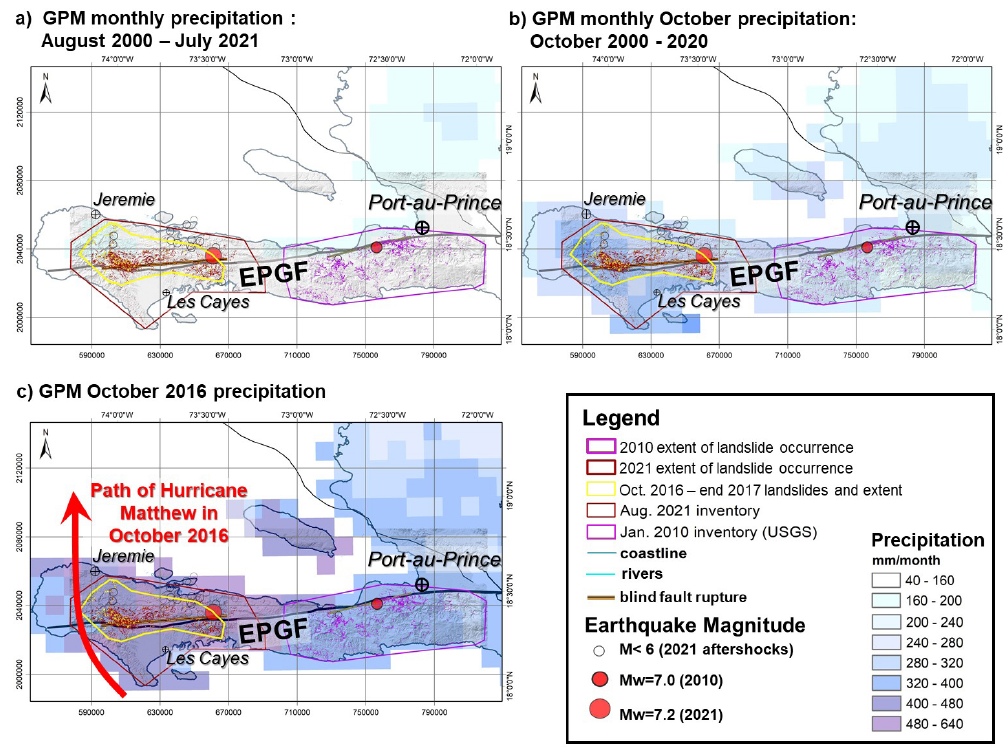
Figure 7. Monthly © Global Precipitation Measurement Mission (NASA) maps (0.1 ◦ resolution, values in millimeters per month) for southwestern Haiti, (a) for all months between August 2000 and July 2021, (b) for the month of October between 2000 and 2020, and (c) for October 2016 (marked by the Hurricane Matthew